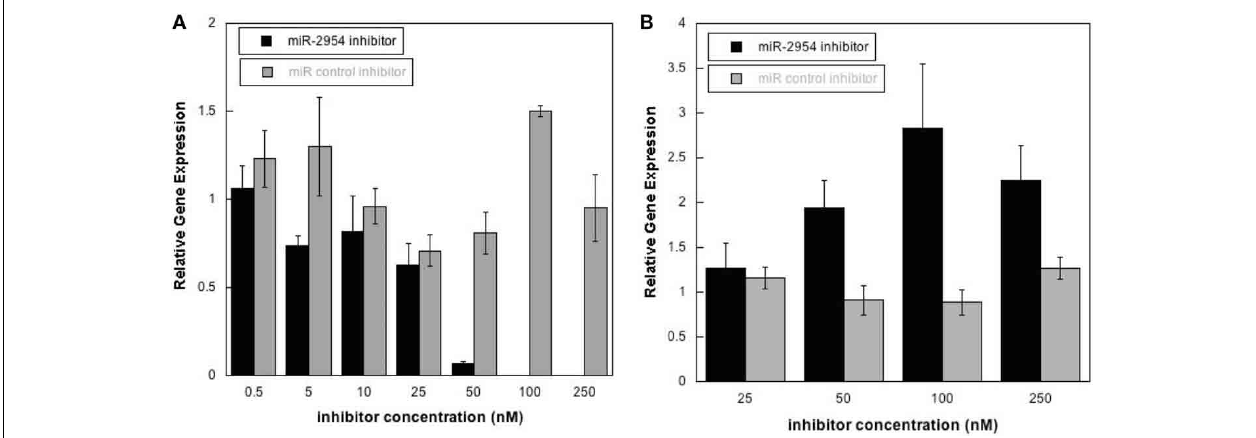
FIGURE 4 | (A) Effects of miR-2954 inhibitor or control dosage on miR-2954 levels in G266 cells, measured by RT-qPCR (linear scale). (B) Effects of miR-2954 inhibitor or control dosage on NR4A3 mRNA levels in G266 cells, measured by RT-qPCR (linear